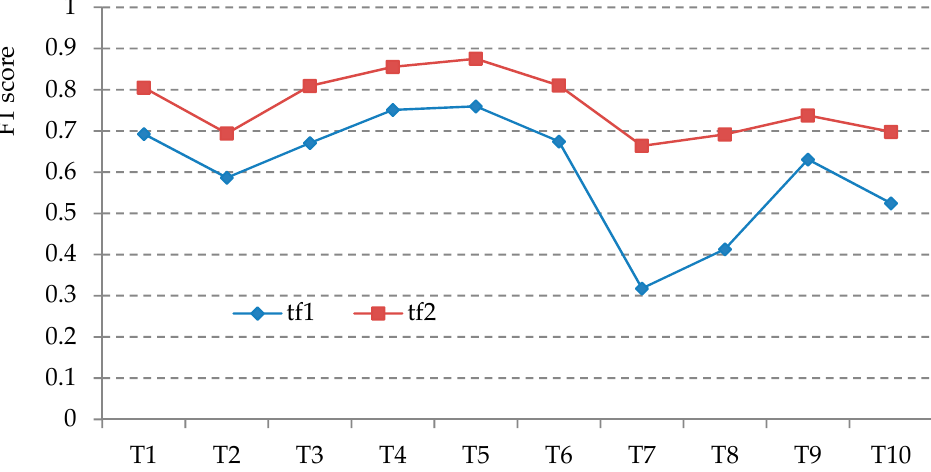
Figure 15. Average F1 scores of 18 models for 10 test data with and without transfer learning.